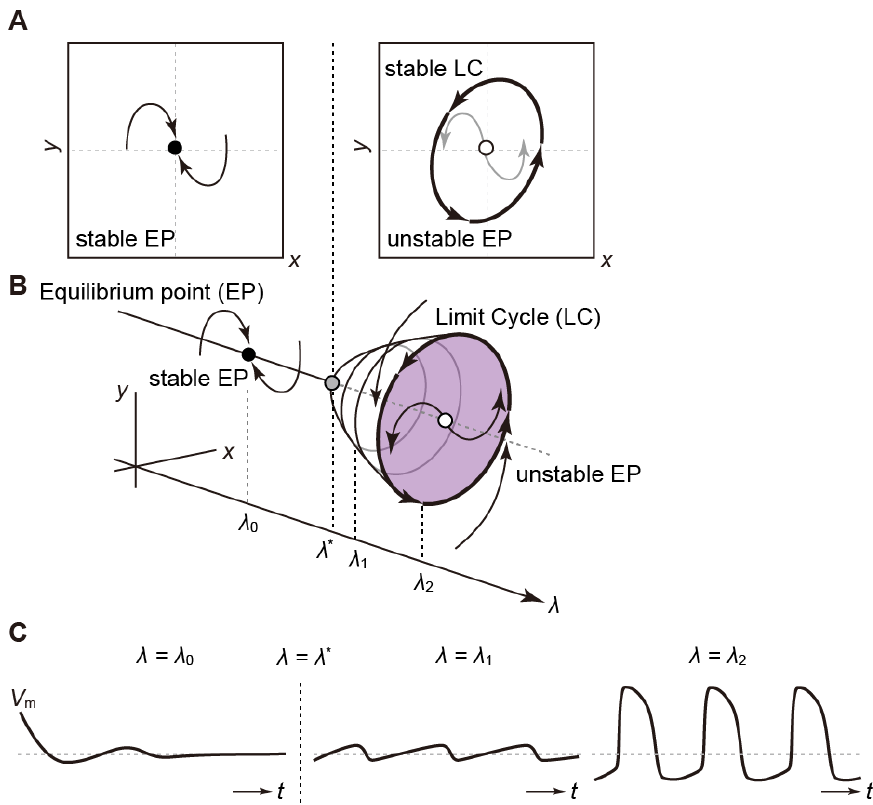
Figure 6. Hopf bifurcation. Examples of the dynamic responses to changes in the parameter λ in the 2-dimensional ( x , y )-state space ( A ) and 3-dimensional ( x , y , λ )-space ( B ). Schematic examples of membrane potential changes at the parameter λ 0 , λ 1 , λ 2 in the 3-dimensional (x, y, λ )-space of panel A ( C ). Changing the system parameter λ , the stability of an equilibrium point (EP) changes via a Hopf bifurcation. Before and after the occurrence of a Hopf bifurcation ( λ *), a stable EP becomes unstable with the emergence of a limit-cycle (LC) oscillation.